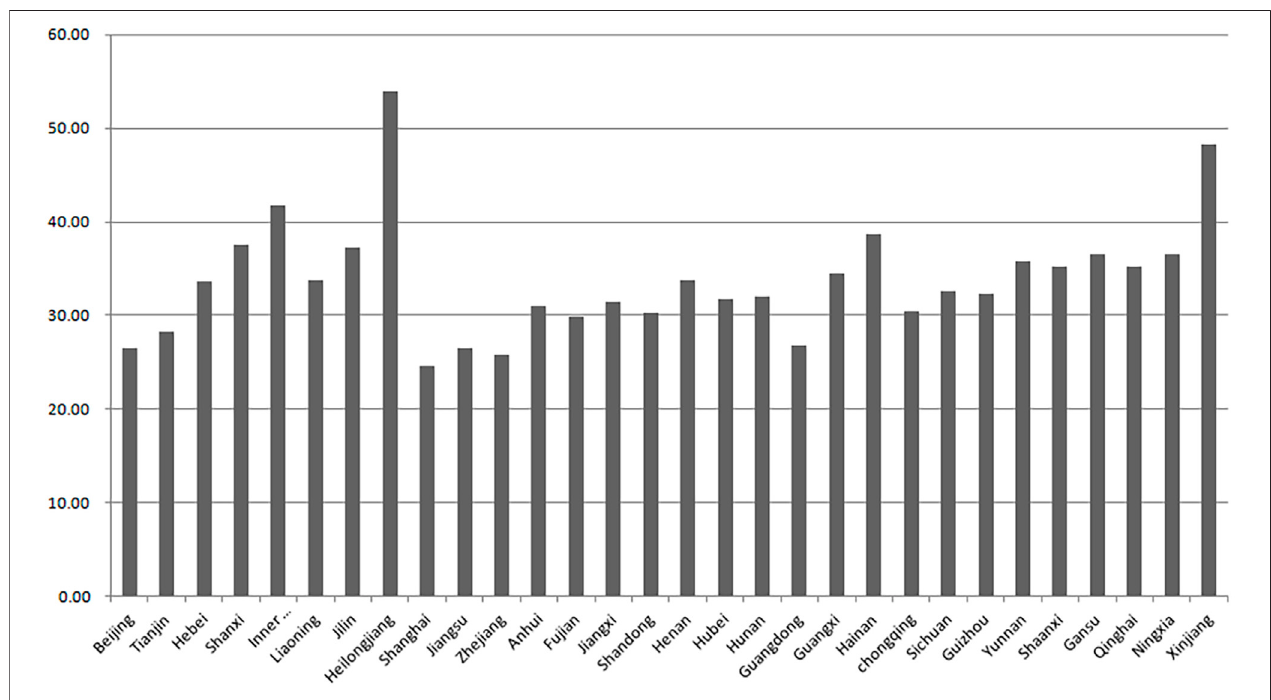
FIGURE 1 | Resource dependence degree of each province in China (average value from 2004 to 2020).